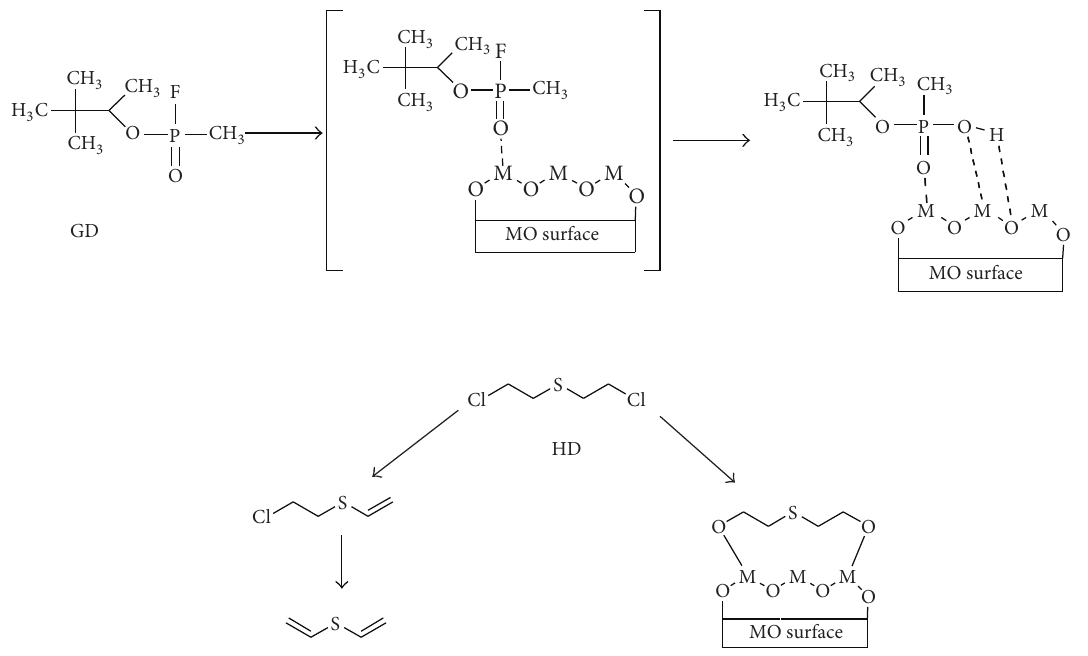
S 1: Decomposition of nerve/blister agents on metal oxide